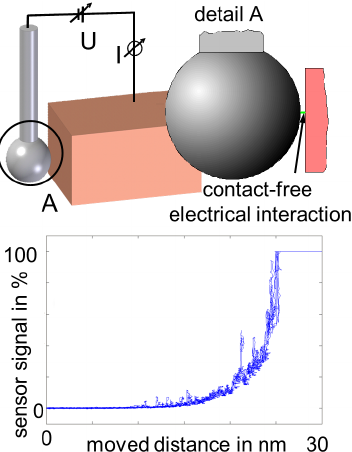
Figure 2. General set-up and characteristic of the electrical 3-D